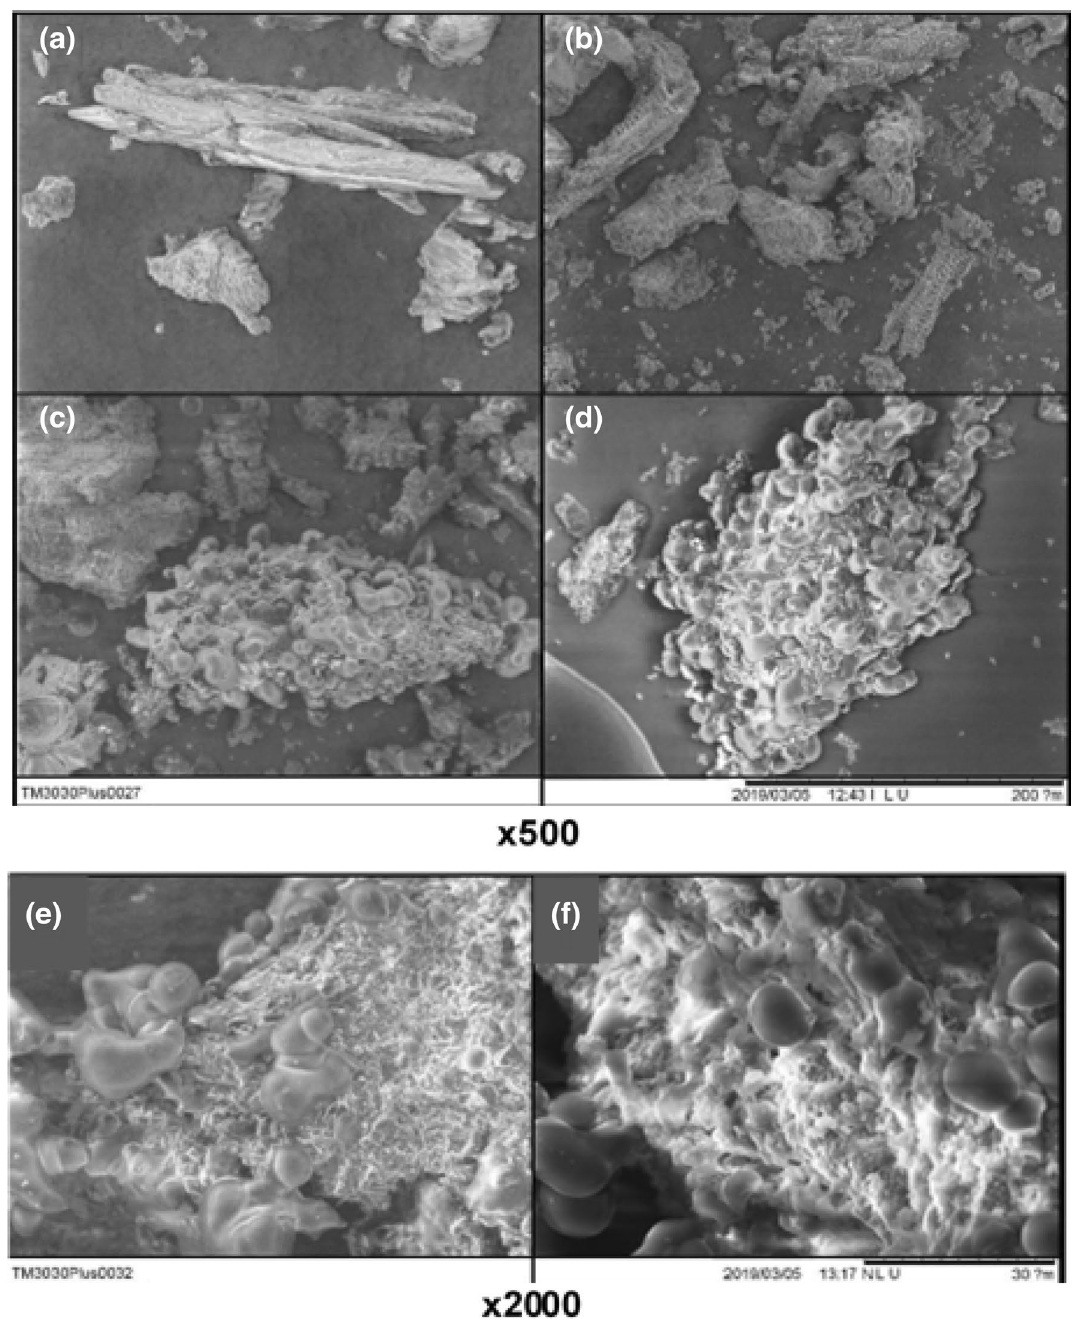
Fig. 2 SEM images at ×500 magnification of a raw coconut shell, b CS-HC200, c CS-HC220, and d CS-HC250. At ×2000 magnification are images of e microsphere formation on the surface of CS-H220, and f microsphere and pore formation on the surface of